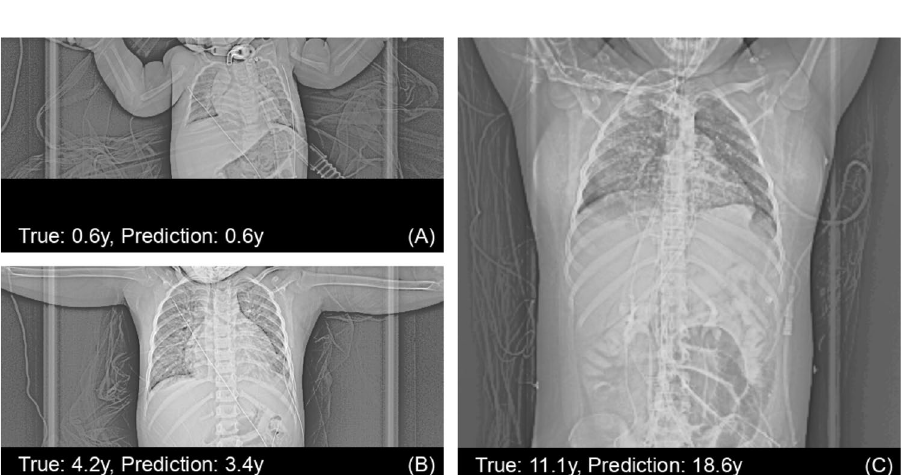
Figure 6. Results of the optimized network retrained on all data, i.e., the training set as well as the validation set, and evaluated on the independent test set. Left : Scatter plot of the ground truth ages ( x -axis) against predicted ages ( y -axis). The dashed lines mark the limits at ± 4 years. Red dots correspond to female patients, blue dots to male patients. Middle : A histogram of the prediction errors. Right : Scatter plot of the ground truth age ( x -axis) against the prediction errors ( y -axis). Red dots correspond to female patients, blue dots to male patients.